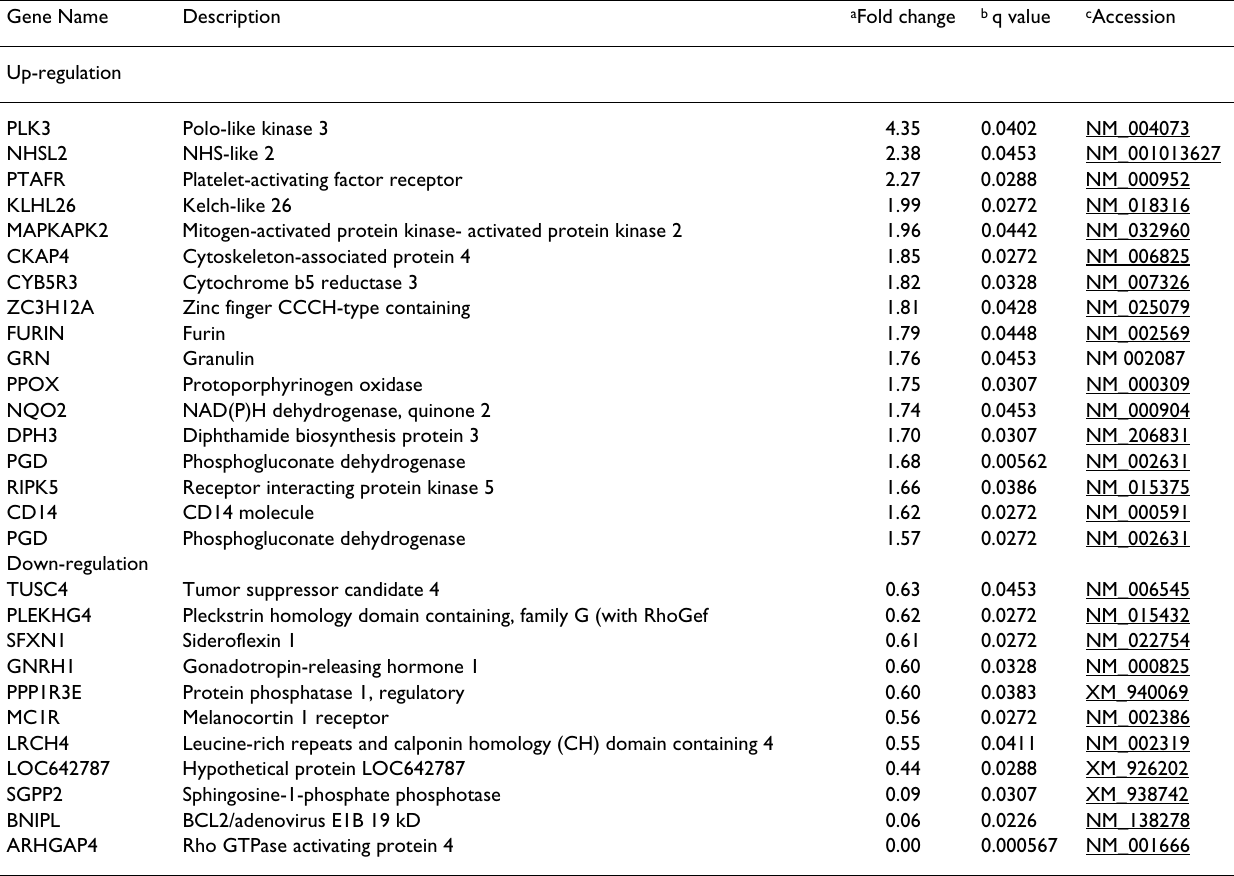
Table 3: Up/down regulated genes in PBMC lacking